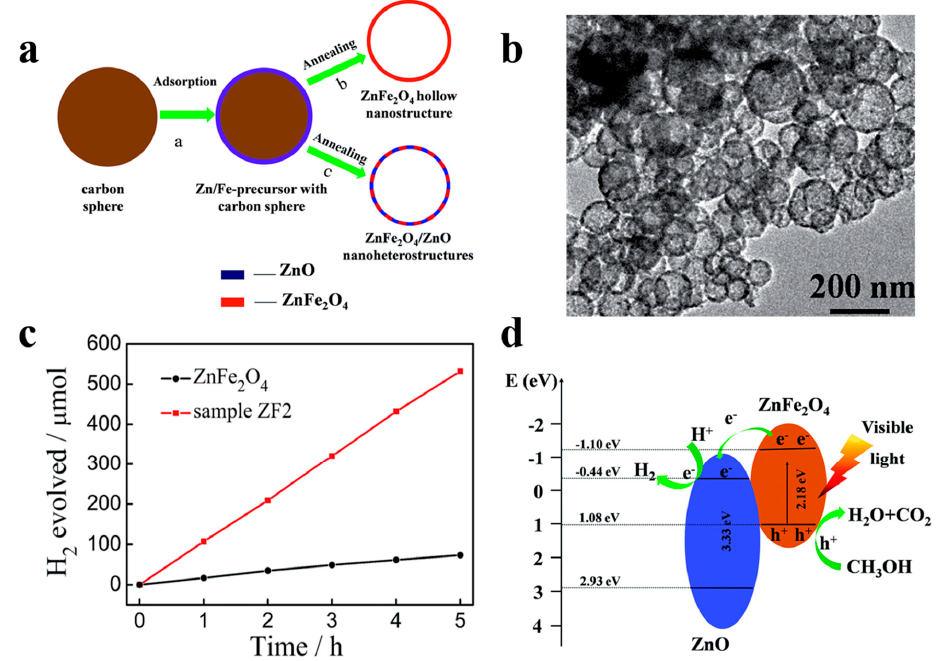
Figure 11. ( a ) Schematic diagram of preparation process of ZnFe 2 O 4 nanostructures and ZnFe 2 O 4 / ZnO nanoheterostructures. ( b ) TEM images of ZnFe 2 O 4 / ZnO spheres. ( c ) H 2 production over time by 50 mg photocatalysts of bare ZnFe 2 O 4 and ZnFe 2 O 4 / ZnO (ZF2) sample driven by visible light ( > 420 nm). ( d ) Schematic illustration of ZnFe 2 O 4 / ZnO hetrtojunction energy band position and predicted reaction mechanism under irradiation. Reproduced with permission from [80]. Copyright Royal Society of Chemistry, 2015.